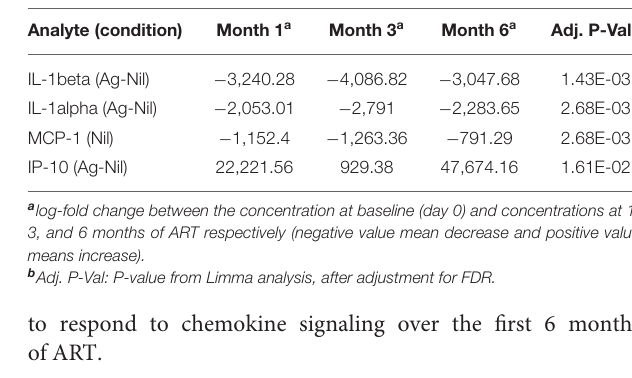
TABLE 3 | Analytes with significant changes from baseline, over the follow up